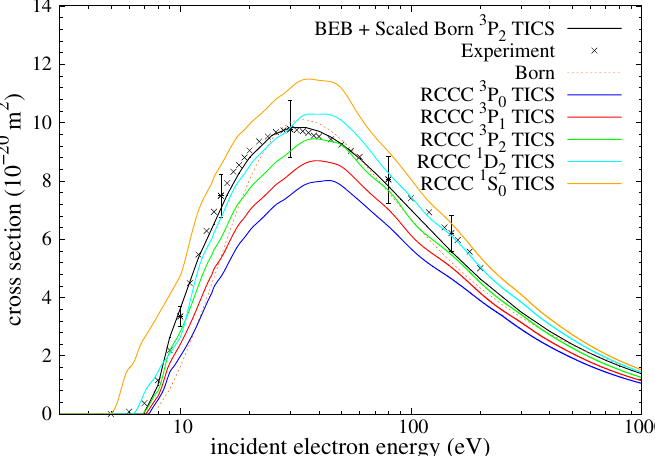
Figure 22. RCCC-extrapolated results for TICS from all states in the 5 s 2 5 p 2 ground configuration. The RCCC cross sections include a sum over DI for both the 5 p and 5 s shells and also include EA. Compared with experimental TICS [13], the BEB and scaled Born result of Kim and Stone [16] for scattering on the 3 P 2 state and the summed Born results of Bartlett and Stelbovics [15]. The error bars on the experimental points indicate the 10% uncertainty associated with the